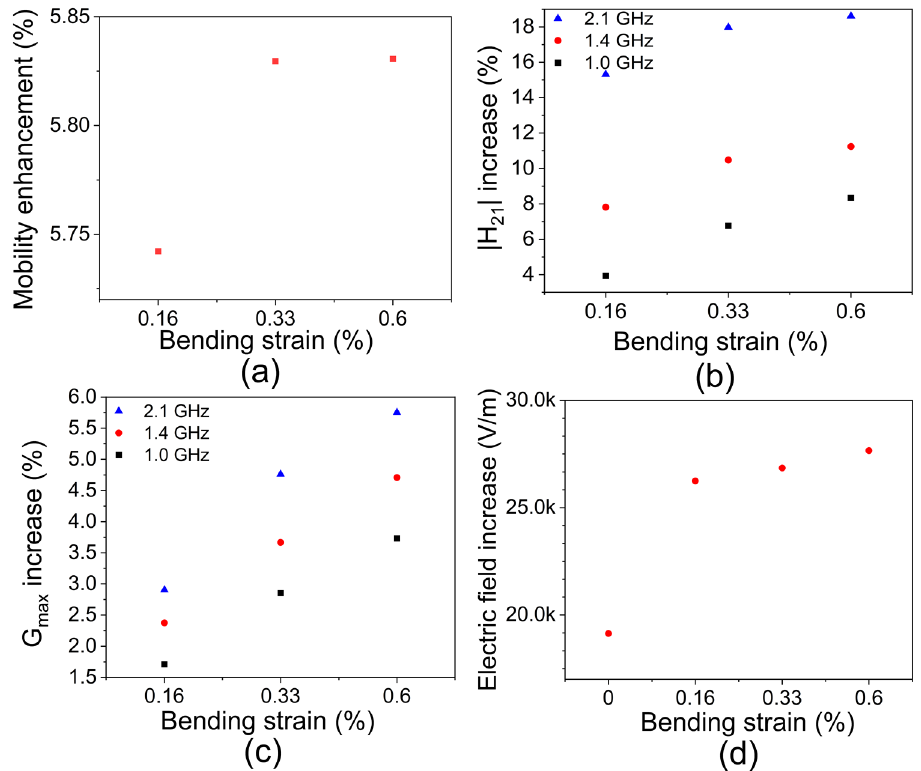
Figure 3. ( a ) n+ carrier mobility enhancement (in percentage) with different bending strains. Change of ( b ) measured H 21 and ( c ) G max of the TFTs (in percentage) at 1.0, 1.4, and 2.1 GHz with different bending strains. ( d ) An electric field with different bending strains.